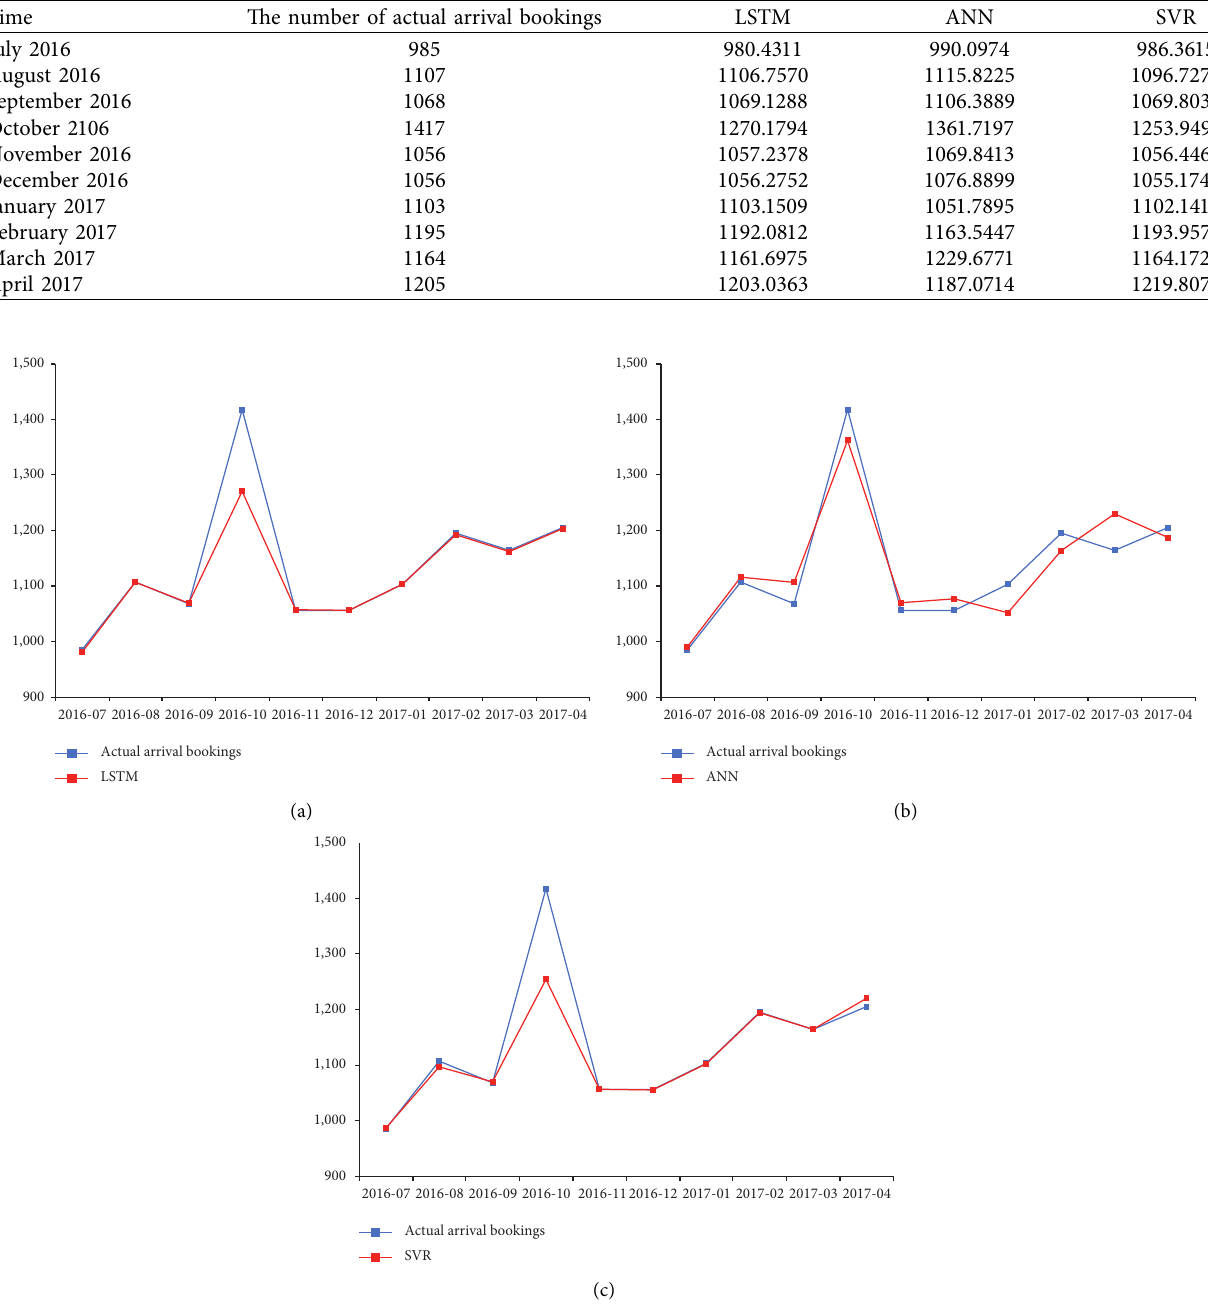
Table 3: Training predictive results of each model.